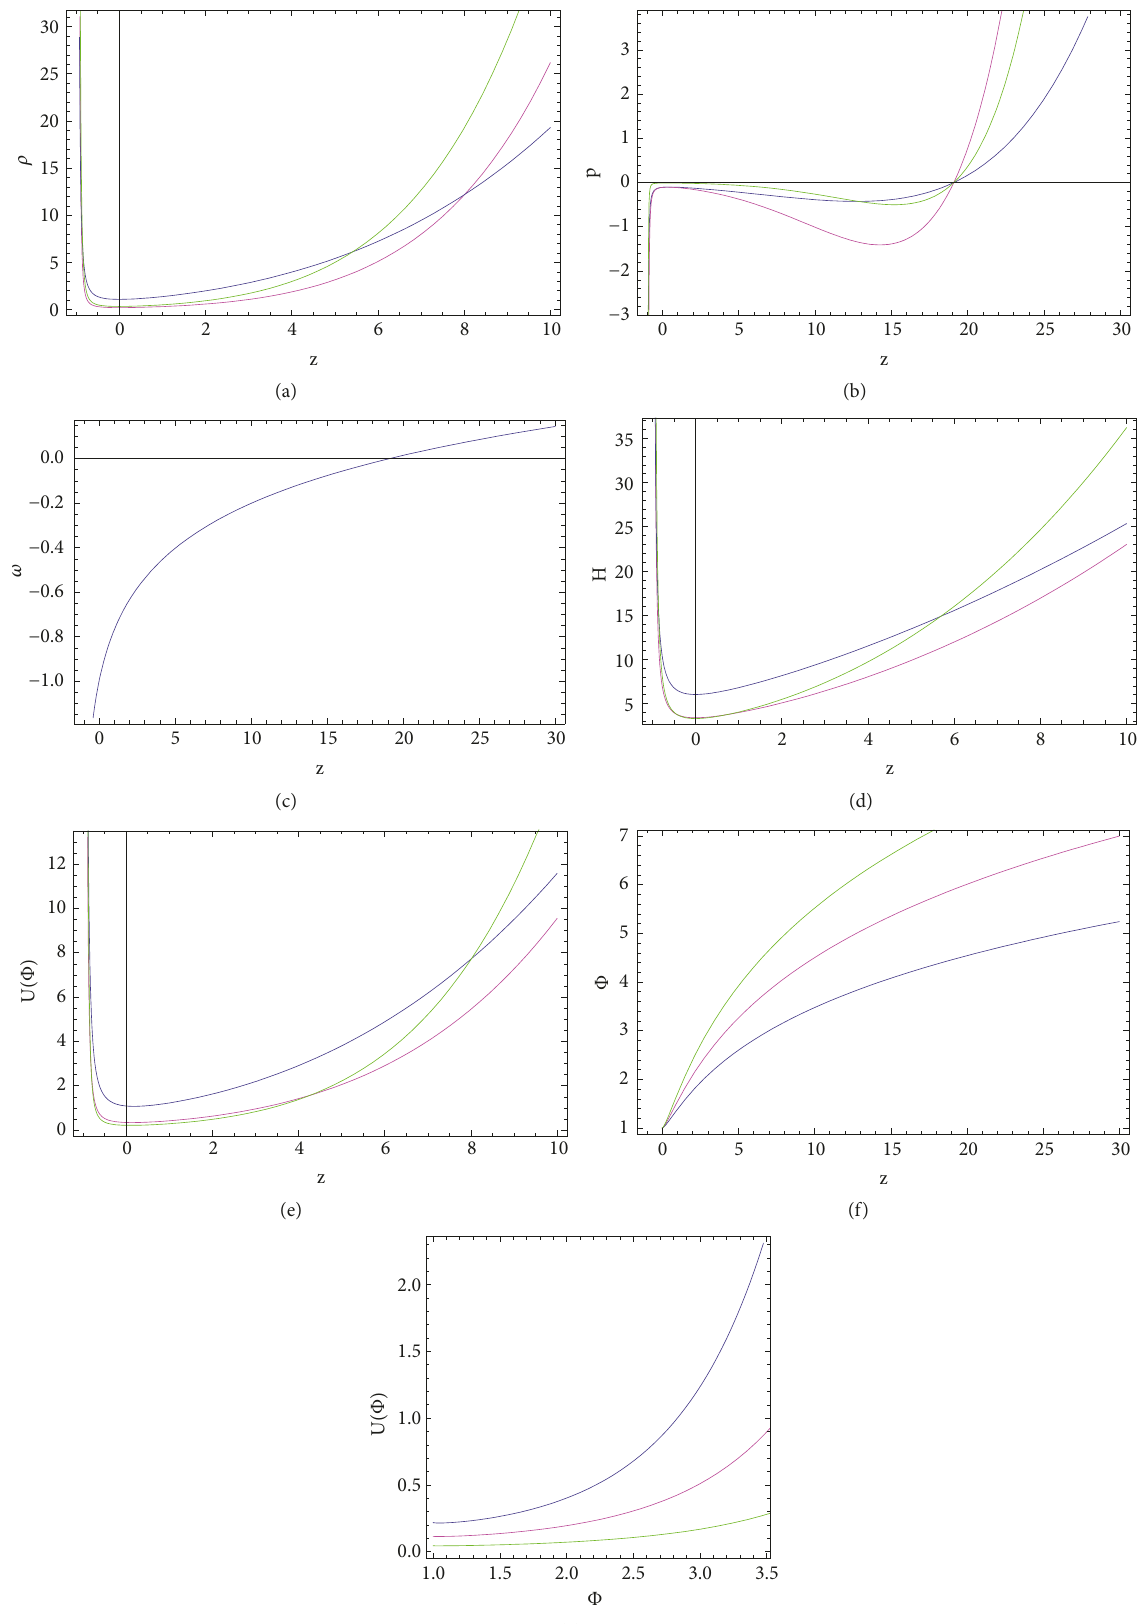
Figure 5: (a), (b), (c), (d), (e), and (f) show the variation of energy density 𝜌 , pressure 𝑝 , EoS parameter 𝜔(𝑧) , Hubble parameter 𝐻 , potential 𝑈(𝜙) , and the scalar field 𝜙 with the variation in 𝑧 for the Efstathiou parameterizations. (g) shows the variation of 𝑈(𝜙) with 𝜙 . Different colored paths are obtained for different values of